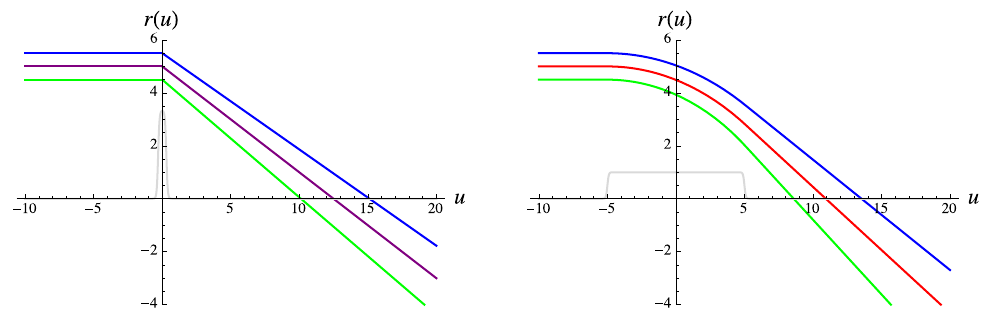
Figure 2 . The left-hand plot shows the behaviour of the radial coordinate r ( u ) of geodesics with di(cid:11)erent impact parameters b as the corresponding test particle is struck by an impulsive gravitational shockwave at u = 0. The right-hand plot shows the same result for an extended gravitational wave burst with pro(cid:12)le (cid:31) F ( u ) = (cid:2)( u; L ) indicated (with a di(cid:11)erent vertical scale) by the grey curve. In this and all subsequent plots, we have taken L = 10.